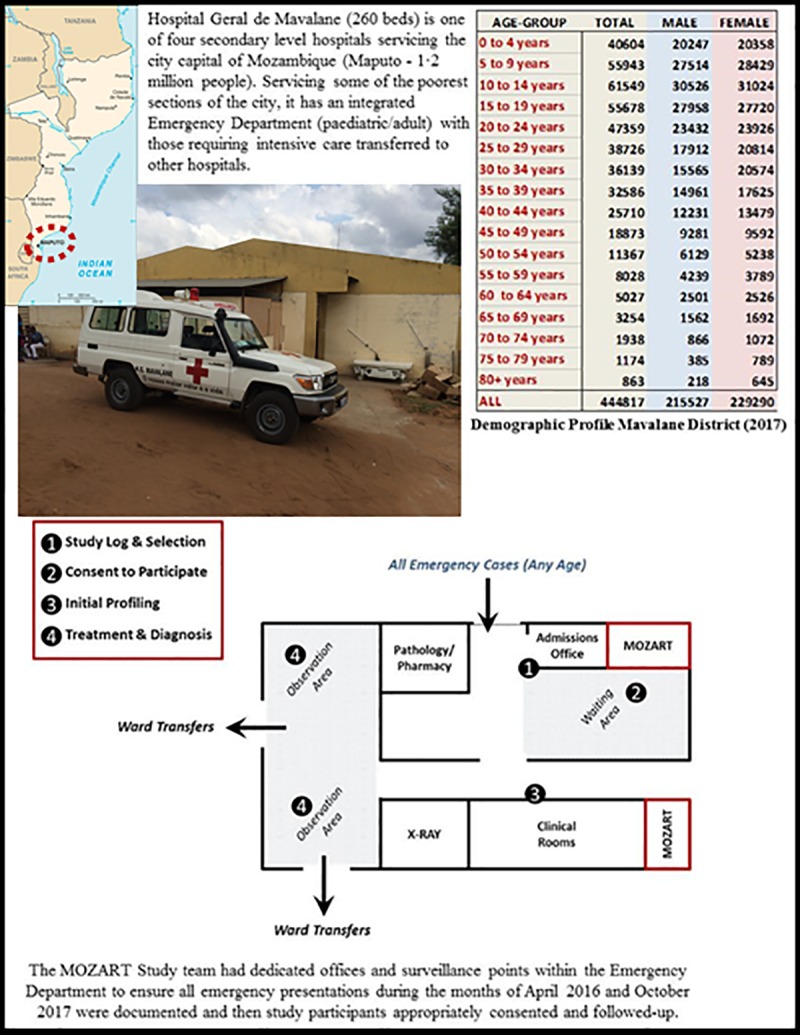
Hospital Geral de Mavalane (260 beds) in Maputo (Southern Mozambique).Public domain map of Mozambique sourced from: https://www.drivingdirectionsandmaps.com/mozambique-google-map/ (Accessed May 2019).